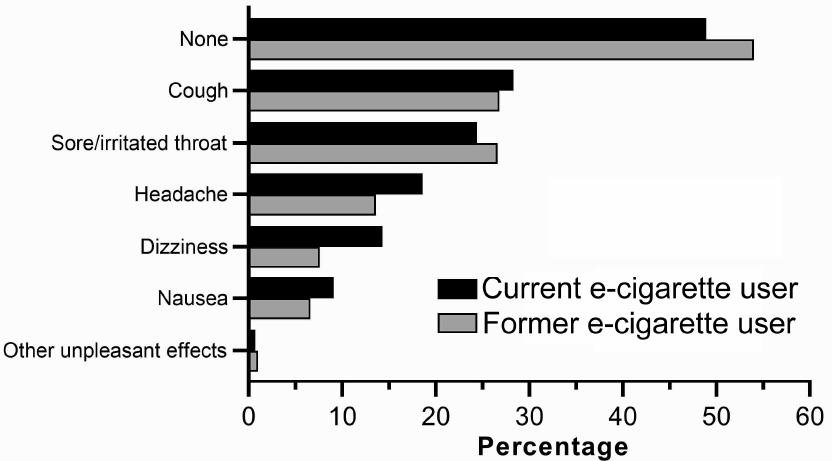
Figure 1. Health effects experienced by Australian adult current and former e-cigarette users. Figure 1. Health e ff ects experienced by Australian adult current and former e-cigare tt e users. Data are % of respondents—with respondents permi tt ed to select more than one health e ff ect. n = 307